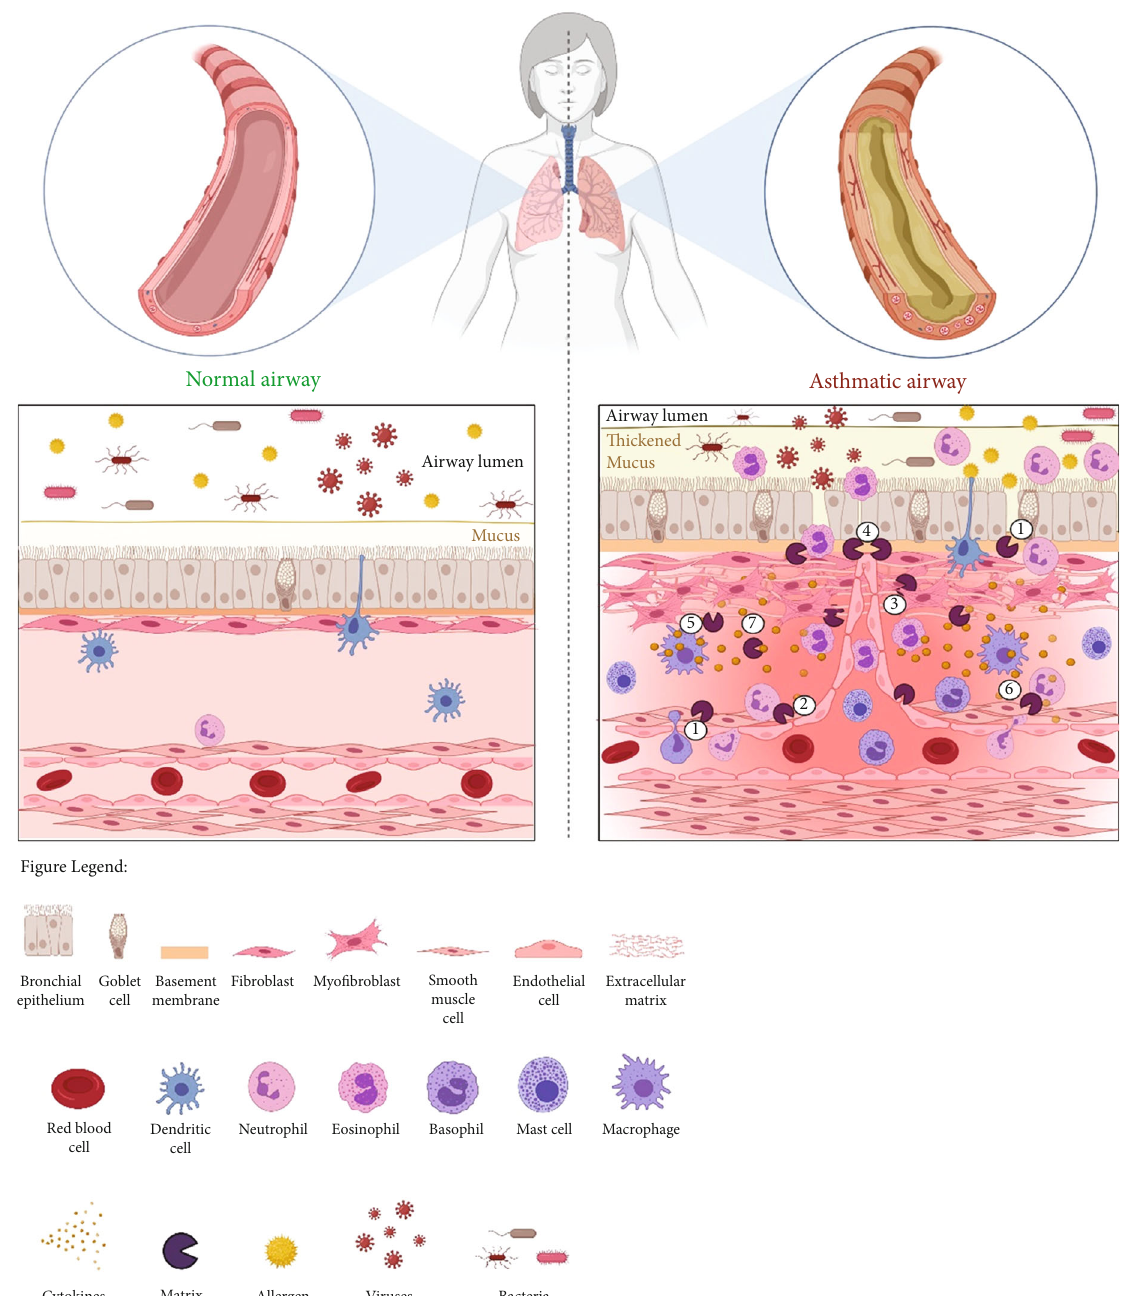
Figure 1: Schematic illustration of the involvement of MMPs in facilitating angiogenesis in asthma. In an asthmatic airway microenvironment, MMPs are involved in (1) the extravasation of in fl ammatory cells into the airways as well as their egress into the airway lumen across the vascular and airway membranes, (2) the degradation of vascular basement membrane, (3) degradation of ECM components (collagen, proteoglycans, elastin, gelatin, fi brin, fi bronectin, aggrecan, and laminin), (4) aiding the endothelial sprouting tip to invade into the surrounding stroma, (5) release of proangiogenic cytokines and growth factors (HIF, VEGF, bFGF, PDGF, and TGF- β ) from ECM, activated airway structural cells (epithelial, endothelial, fi broblast, and smooth muscle cells), and in fi ltrating in fl ammatory cells (eosinophils, neutrophils, basophils, mast cells, and macrophages), (6) regulation of perivascular or smooth muscle cells, and (7) ectodomain shedding of cytokines and their cognate receptors. This complex interplay between the activated cells, MMPs, cytokines, and growth factors directs the development of a vascular network within asthmatic airways. Created with